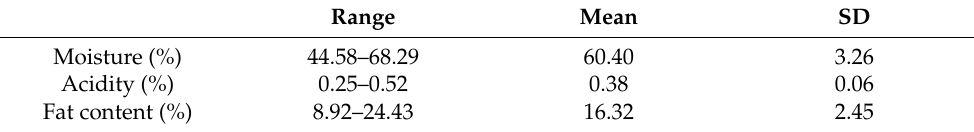
Table 2. Statistics for the olive fruit dataset in relation to moisture, acidity, and fat content.